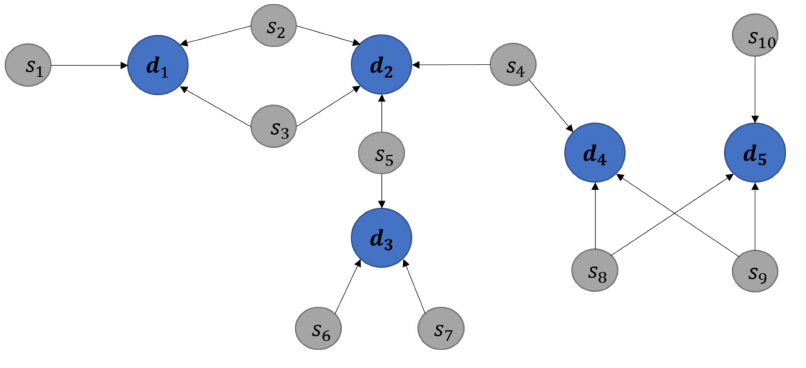
Figure 2. The toy problem